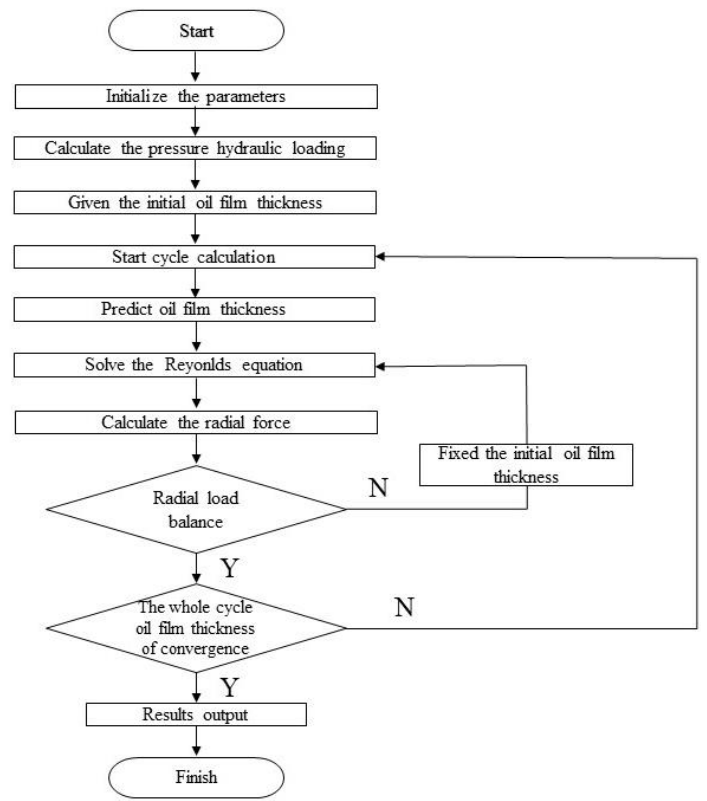
Figure 1. Calculation process.